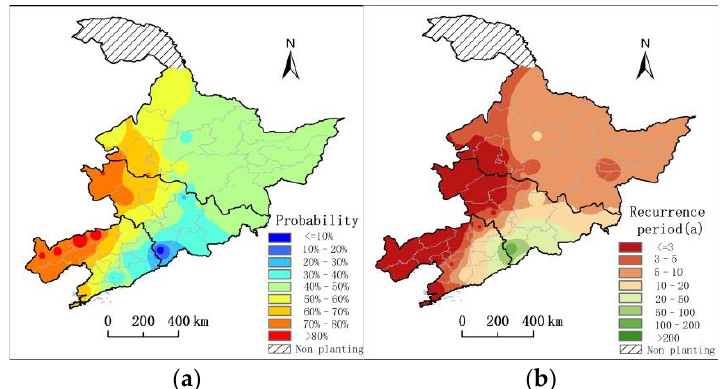
( b ) ( c ) Figure 8. Temporal variations in drought intensity in Liaoning ( a ), Jilin ( b ), and Heilongjiang ( c ) from 1981 to 2020. 3.6.2. Spatial Distribution Characteristics of the Agricultural Drought Event Joint Proba- bilities and the Co-Occurrence Recurrence Periods Figure 9 shows the spatial distributions of the joint probabilities and co-occurrence- recurrence periods for bivariate (drought duration and drought intensity) features of ag- ricultural drought events in Northeast China. The joint probability of an agricultural drought event showed a decreasing trend from west to east. The distribution trend for the co-occurrence-recurrence periods showed an opposite trend, with the high probability area corresponding to the low recurrence period area. This indicated that the joint proba- bility of the occurrence of drought was higher in drought-prone areas. As shown in Figure 9a, the high drought value areas were in western and southern Liaoning, western Jilin,